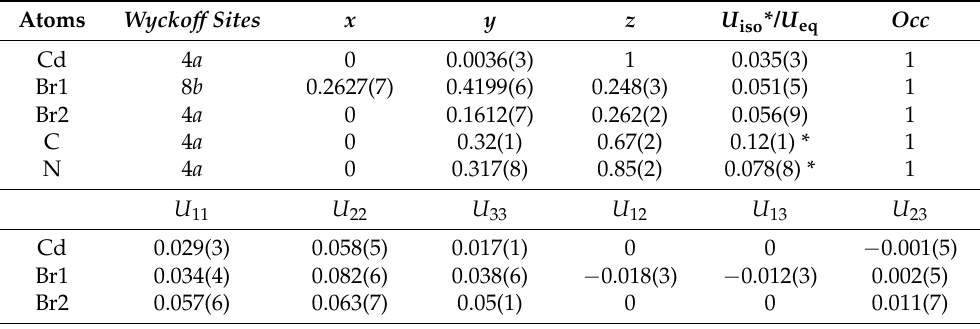
Table 1. Structural parameters for CH 3 NH 3 CdBr 3 from the Rietveld refinement in the orthorhombic Cmc2 1 (No 36) space group, with a = 7.91722(5) Å, b = 13.7108(1) Å, c = 6.89374(2) Å, V = 748.33(1) Å 3 , Z = 4, from SXRD data at 295 K.